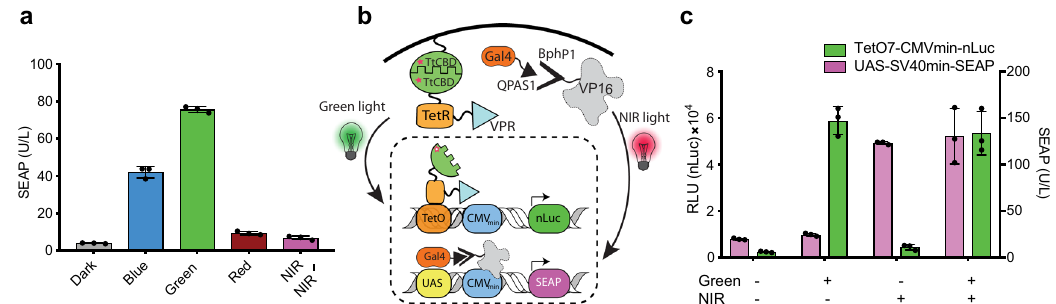
Fig. 4 Function and application of Glow Control system at different wavelengths. a Activation of the Glow Control system in response to light of different wavelengths. HEK293T cells transfected with pMMZ284 (P SV40 -Myr-TtCBD-nGFP-pA), pMMZ272 (P SV40 -TtCBD-TetR-VP16-pA), and pTS1017 (P TetO7- μ W/cm 2 ), green (545nm, 88 μ W/cm 2 ), red (660 nm, 8 μ W/cm 2 ), and NIR (740 nm, 1 mW/cm 2 ) CMVmin -SEAP-pA) were exposed to blue (475 nm, 88 light. SEAP levels in the supernatant of cultured cells were pro fi led at 48 h after the start of illumination. b Spectral multiplexing of the Glow Control and BphP1-Q-PAS1 systems. HEK293T cells were transiently co-transfected with Glow Control constructs (pMMZ284, pMMZ272, and pLeo1403; P tetO7- CMVmin -nLuc-Fc-pA) and BphP1-Q-PAS1 (pQP-T2A; P CMV -BphP1-VP16-T2A-Gal4DBD-QPAS1-pA, and pSP30; P UAS5 -SEAP-pA) systems in a 1 : 1 ratio. c Cells co-transfected with Glow Control and BphP1-Q-PAS1 systems were incubated either without illumination, or illuminated with pulsed green light (545 nm, 12 h/day, 15 s ON/45 s OFF, 88 μ W/cm 2 ), NIR (740 nm, 24 h/day, 30 s ON/180 s OFF, 1 mW/cm 2 ), or illuminated with both green light from the top and NIR from the bottom. The medium was supplemented with 10 μ M B 12 and 25 μ M biliverdin. SEAP and nLuc levels in the supernatant of cultured cells were measured at 48 h after the start of illumination. Plots show the mean ± SD of n = 3 biologically independent samples. Source data are provided as a Source Data fi le.